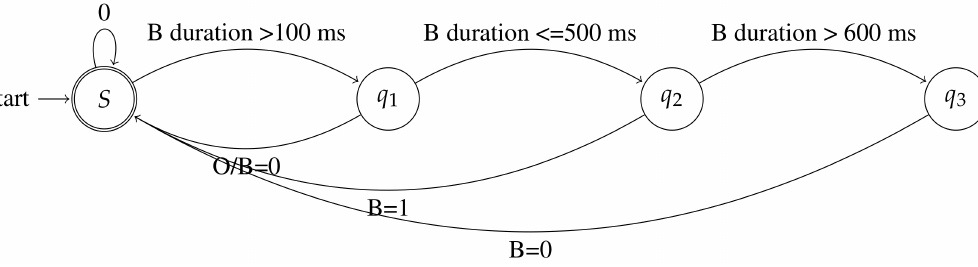
Figure 5. Finite state machine for blink duration